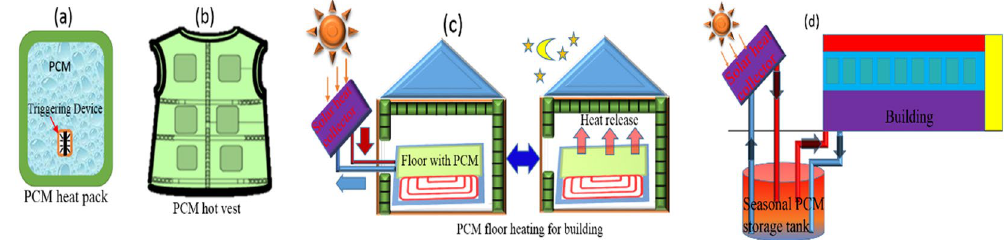
Figure 1. Schematic representation for use of sodium acetate trihydrate PCM in ( a ) reusable PCM heat pack, ( b ) PCM hot vest, ( c ) PCM floor heating for buildings and ( d ) seasonal solar thermal energy storage and building